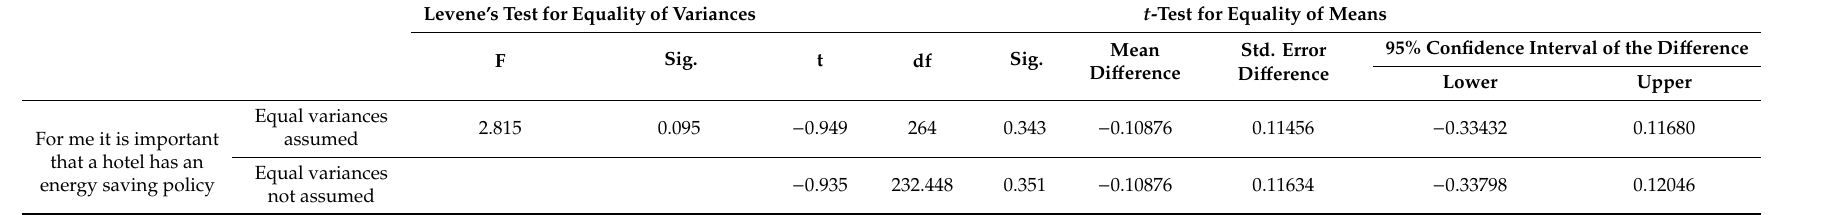
Table 8. t -Test comparing the importance for the hotel to have an energy-saving policy by